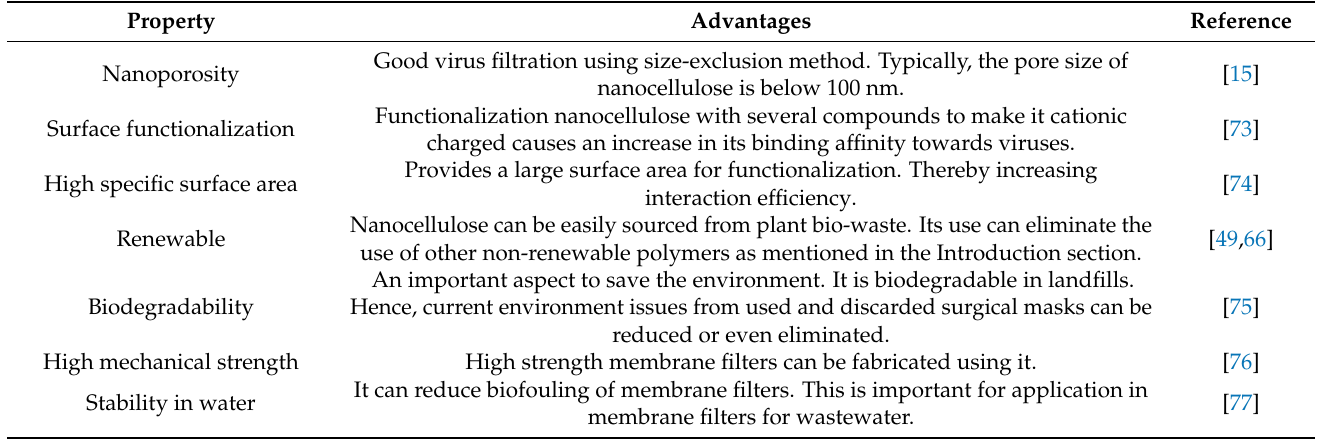
Table 4. Certain interesting properties of nanocellulose related to membrane filtration materials.